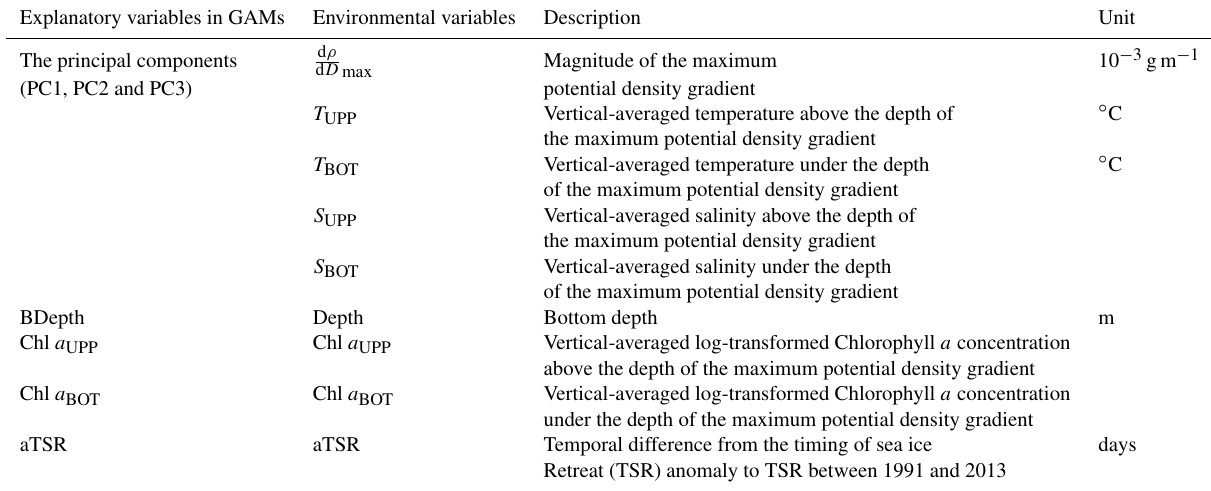
Table 3. The covariates for principal component analysis and explanatory variables for generalized additive models (GAMs). Explanatory variables in